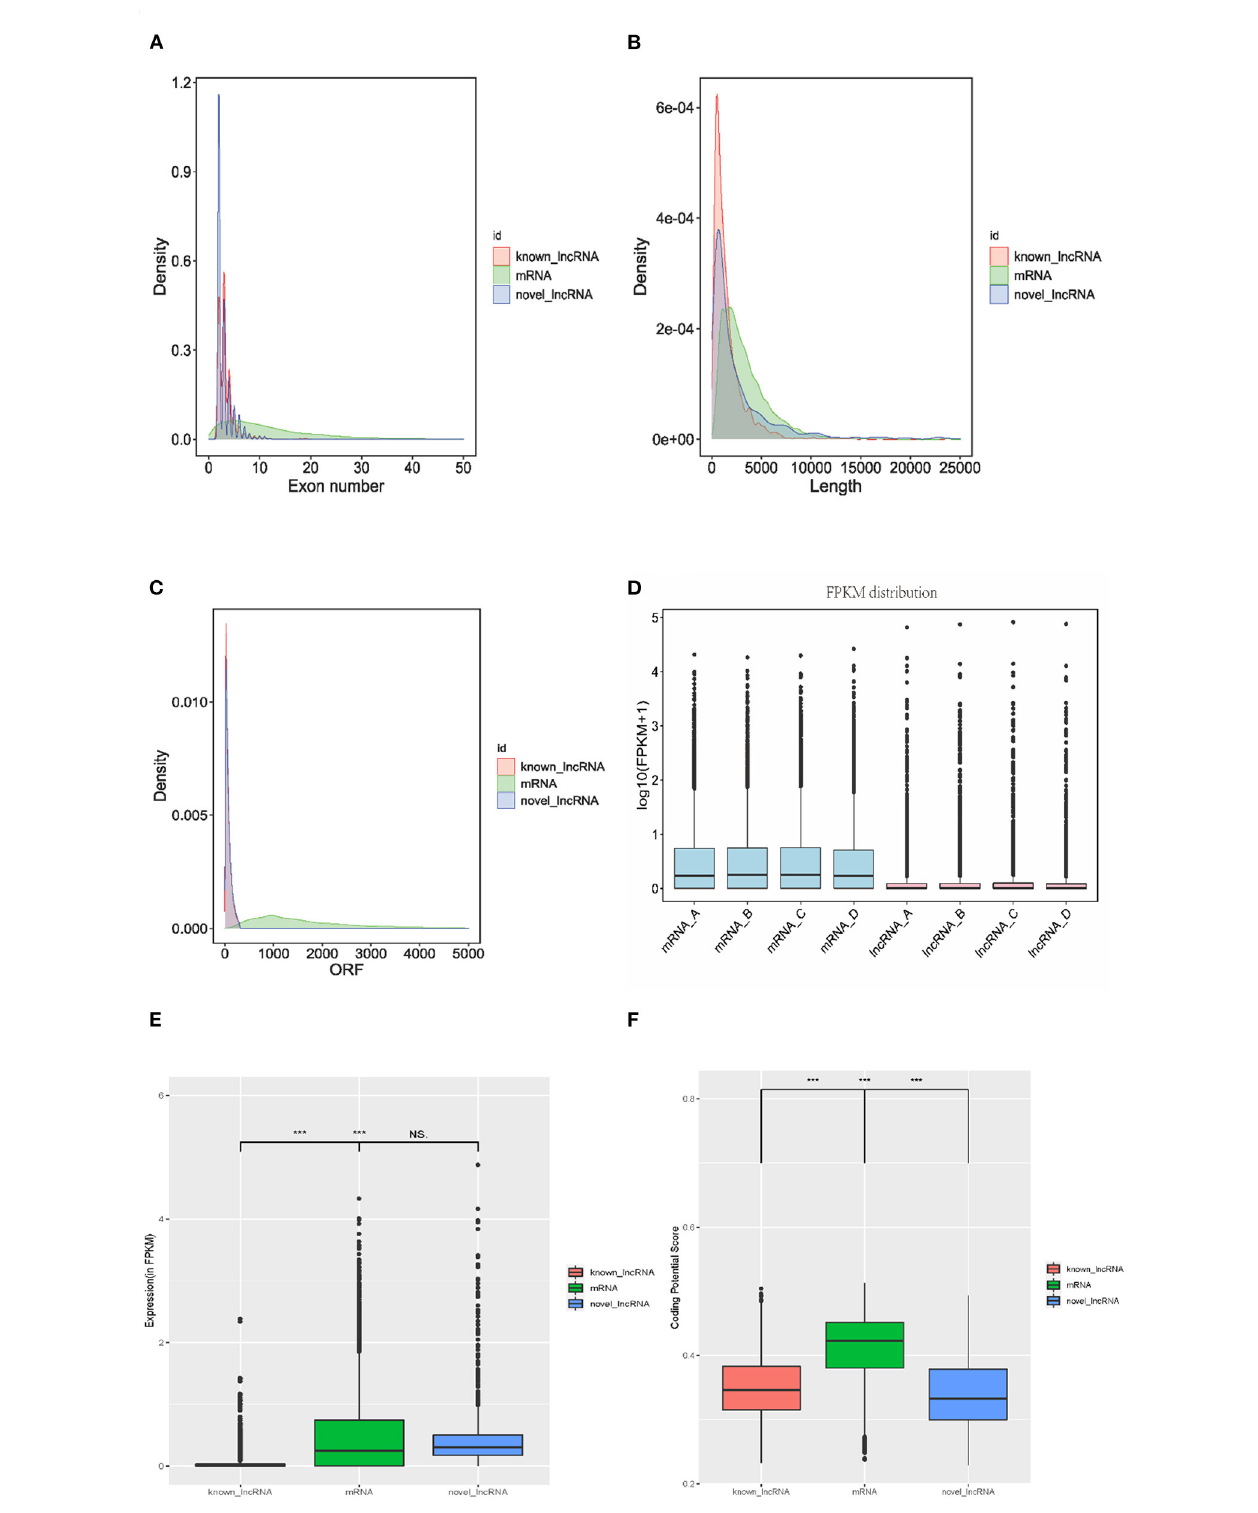
FIGURE 3 | Characteristics of identified lncRNAs. (A) Distribution of exon numbers of mRNA, known lncRNAs, and novel lncRNAs. (B) Distribution of transcript lengths of mRNA, known lncRNAs, and novel lncRNAs. (C) Distribution of open reading frame (ORF) length of mRNA, known lncRNAs, and novel lncRNAs. (D)